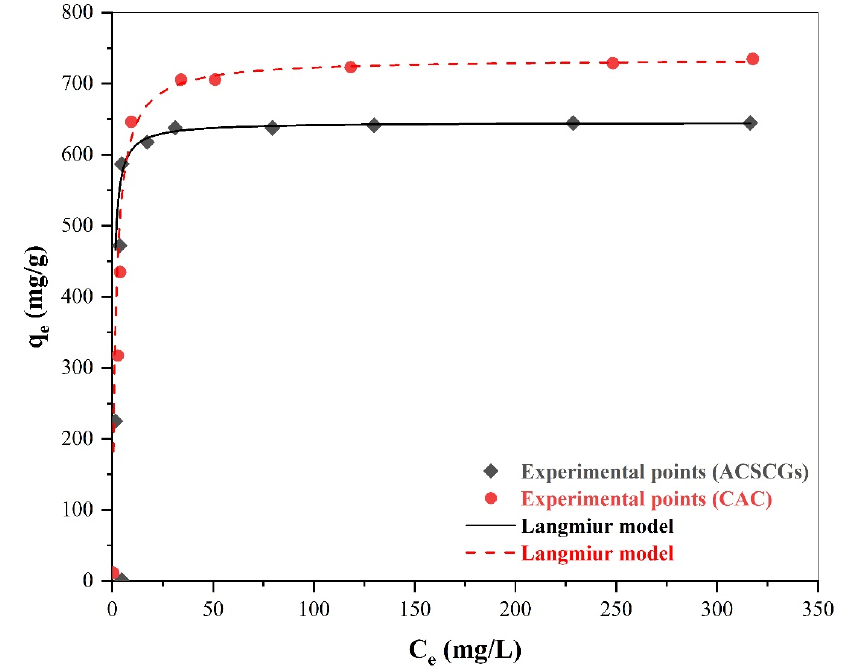
Figure 6. Adsorption isotherm of methylene blue on ACSCGs and on